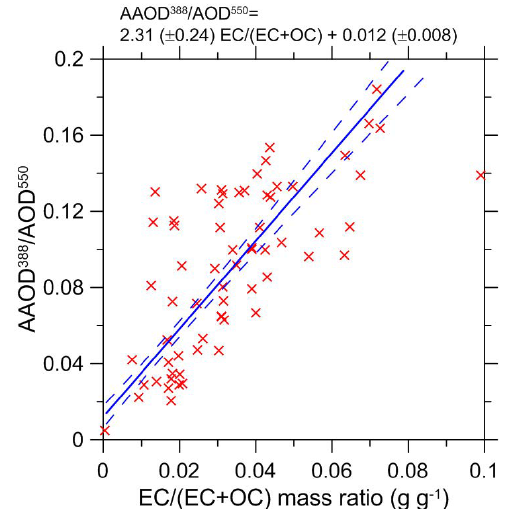
Figure 4. The ratio of AAOD at 388nm and AOD at 550nm as a function of the ratio of the elemental to total carbon in BB aerosol. Both ratios (depicted by red crosses) were derived from observa- tions at the Tomsk-22 and Yakutsk AERONET sites. A linear re- gression fitted using the ODR method and 1- σ (68.3%) confidence intervals of the fit are shown using solid and dashed blue lines, re- spectively. The best fit equation is given at the top of the